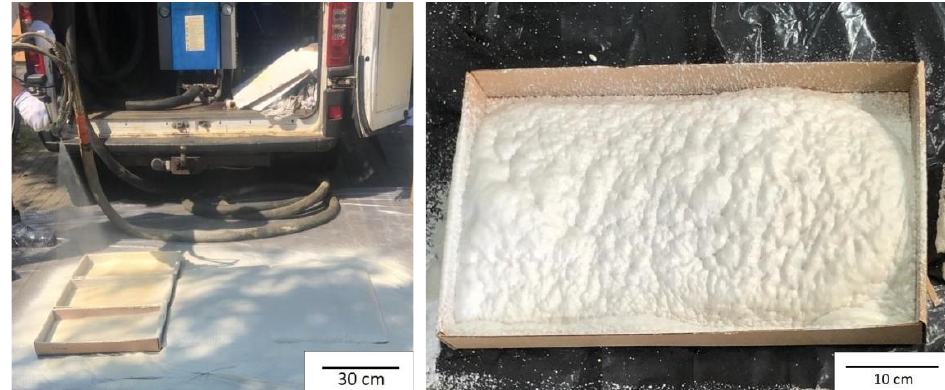
Figure 7. Samples prepared on an industrial scale.